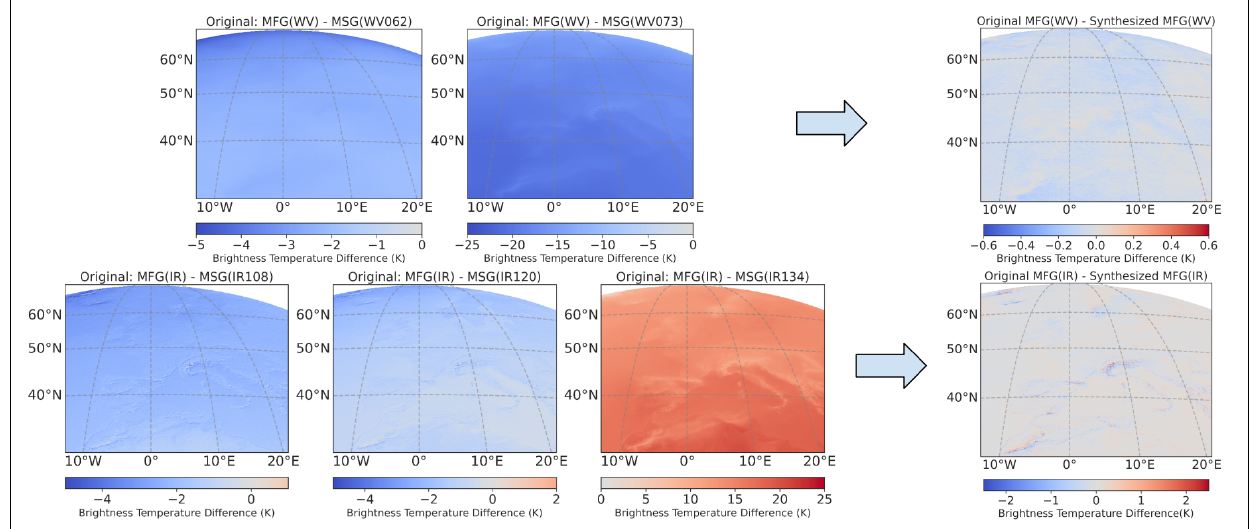
Figure 12. Mean composite differences between MFG and MSG original channels ( left ) and MFG original and synthesized channels ( right ). The top row represents the mean composite differences for the WV channels and the bottom row for the IR